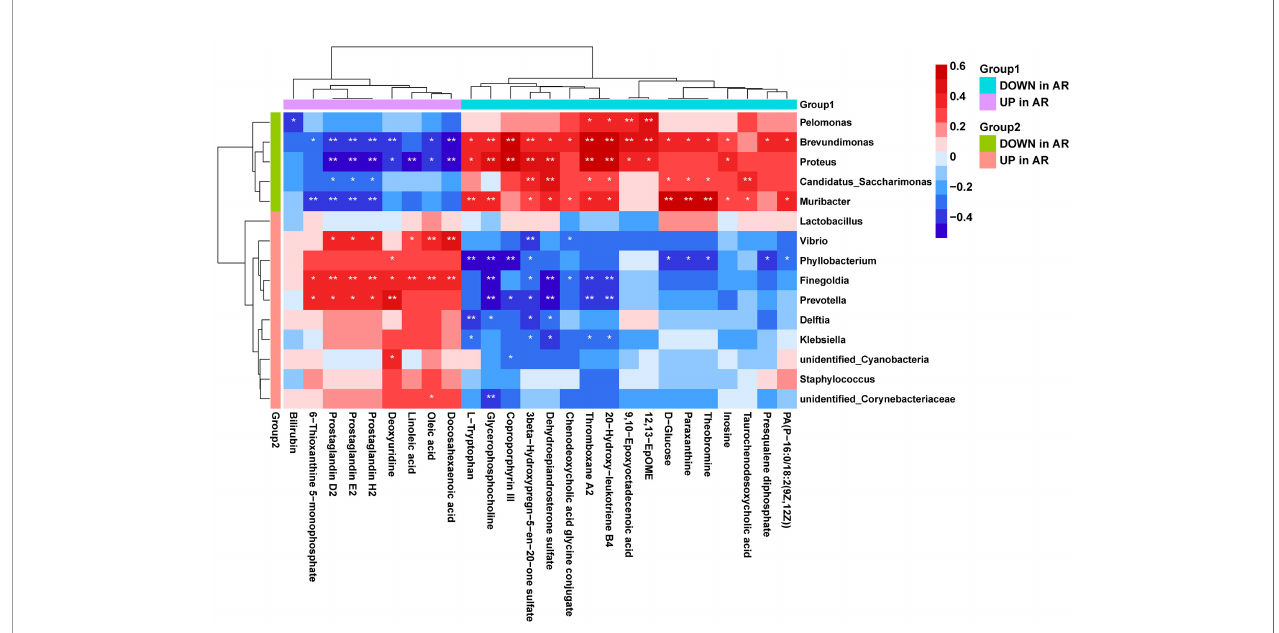
FIGURE 8 | Correlation analysis of the microbiome and metabolome. Spearman ’ s correlation analysis was conducted using potential microbiome biomarkers of AR and potential metabolite biomarkers. Student ’ s t-test, *p < 0.05, **p <